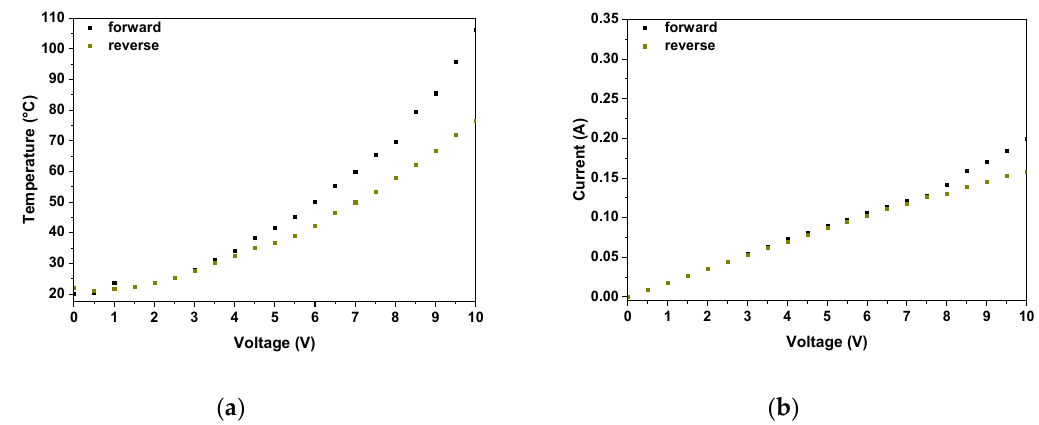
Figure 8. The correlation of temperature ( a ) and current flow ( b ) versus applied potential in forward and reverse mode for devices with the architecture glass / ITO / bTAThDaz / Ag / ITO / glass.